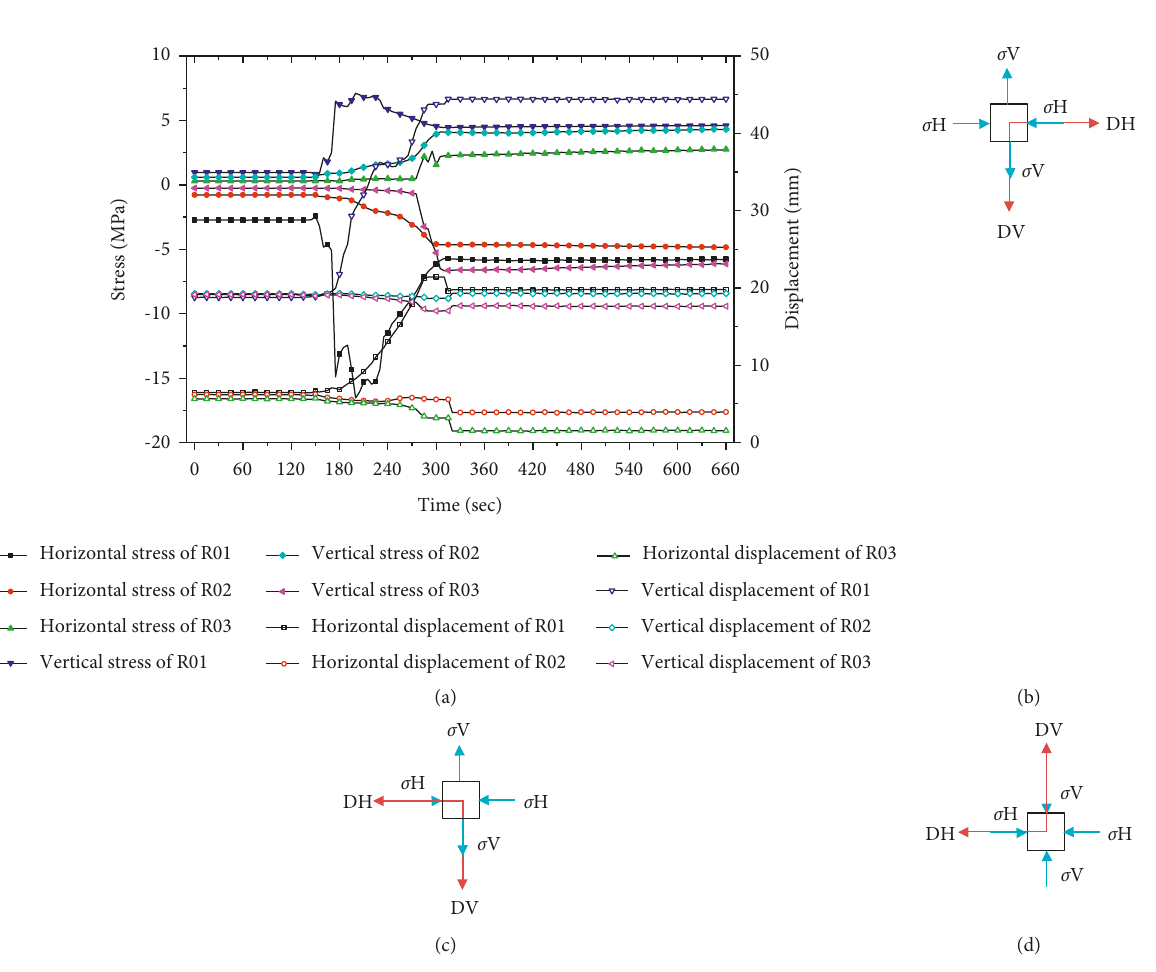
Figure 17: Stress and displacement of roadway roof measuring points when the cumulative duration is 539 to 550mins; (a) monitoring curve of R01, R02, and R03; and (b–d) schematic diagram of R01, R02, and R03,